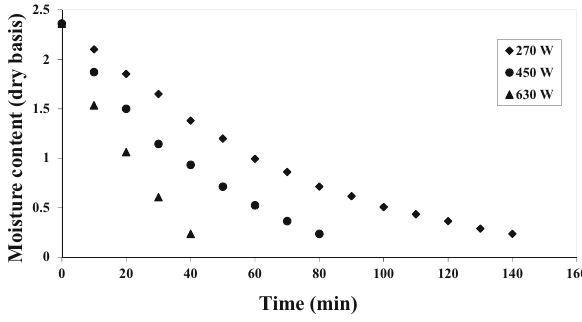
Figure 2: Experimental drying curves for microwave drying of pomegranate arils under di ff erent microwave powers, in the form of dry basis moisture content versus drying time.